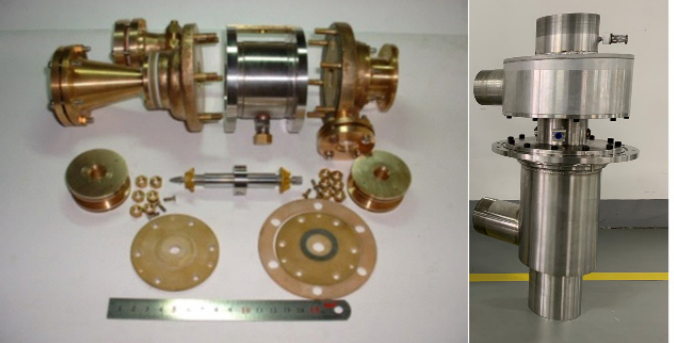
Figure 16. The air turboexpander and hydrogen turboexpander using ATBs by Xi’an Jiaotong Uni ‐ versity.